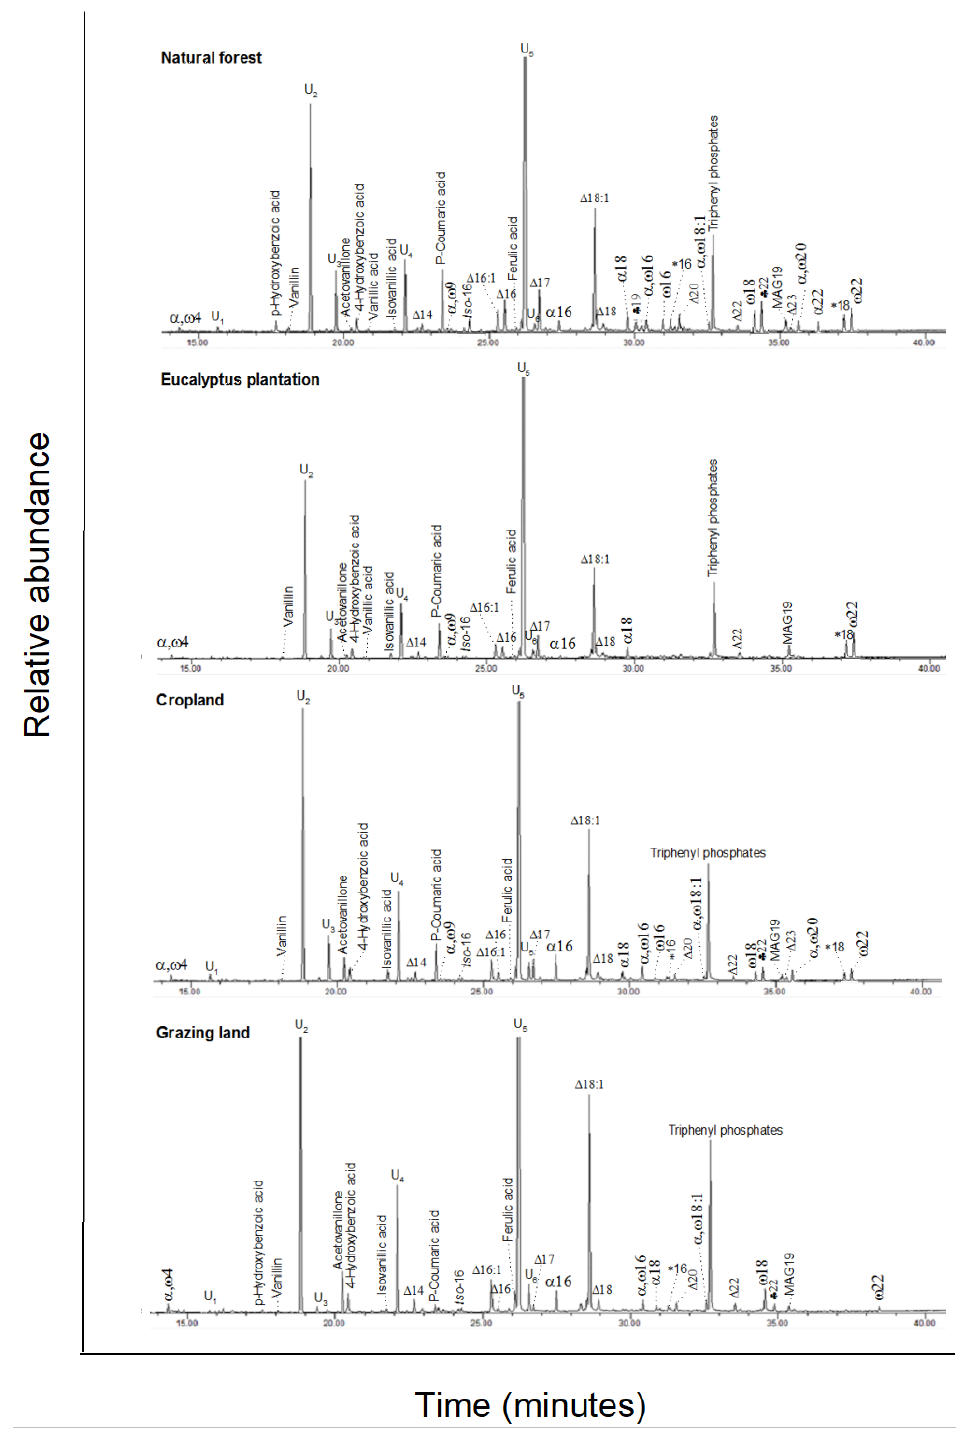
Figure A3. Total ion GC – MS chromatograms (TIC) of the methylated and silylated extracts after base hydrolysis of four land-use systems from Gelawdios, Ethiopia. Notes: , n -alkanols; +, n -al- kanes; Δ, n -alkanoic acids; iso- alkanoic acids; α - alkanoic acids; α,ω - alkanedioic acids; ω -hydroxyal- kanoic acids; * Mid chain substituted hydroxy acids; #, MAG, m onoacylglycerides; steroids (β -sit- psterol); organophosphate; phenols; and U 1 – U 5 , unidentified. Numbers refer to total carbon num- bers in aliphatic lipid series. Detailed description of each compound, with its quantity, molecular formula, and molecular weight, is in Appendix Table A2.